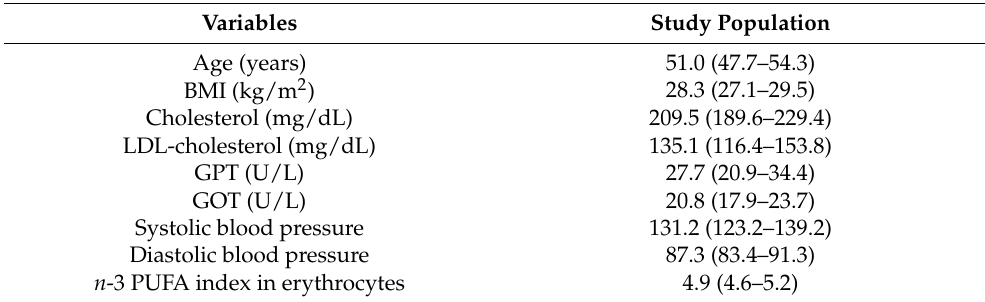
Table 2. Demographic data and baseline characteristics ( n = 19, at screening). Data are shown as means (95%